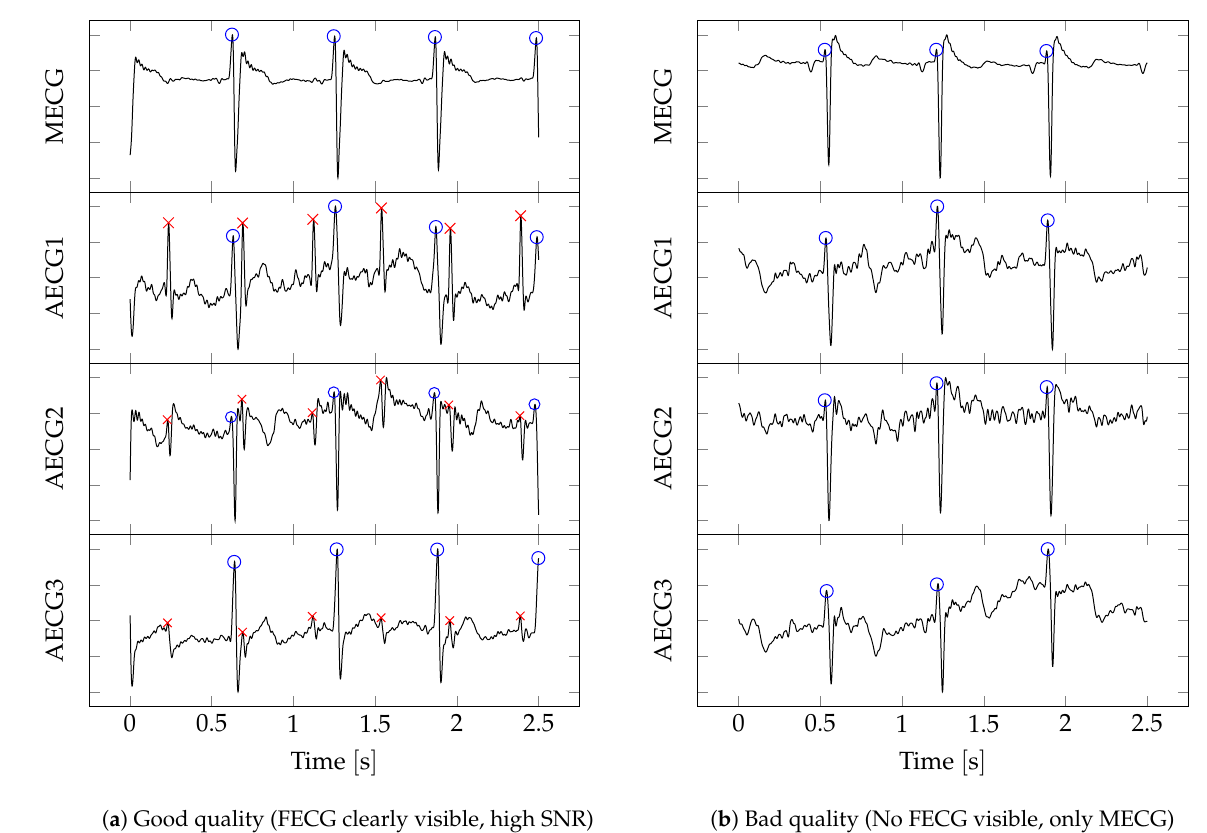
Figure A2. Examples of good- and bad-quality segments. Blue circle: maternal R peak, red cross: foetal R